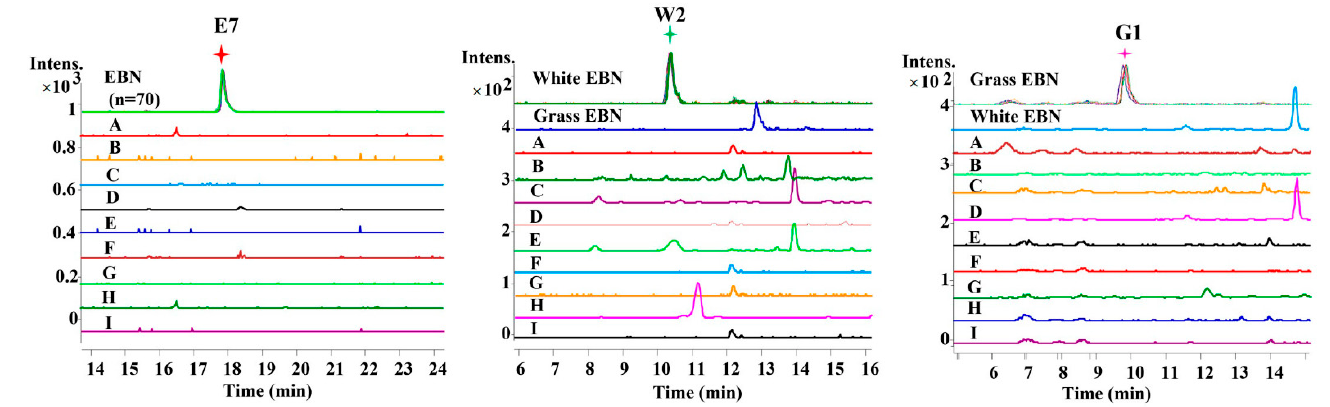
Figure 3. Extracted ion chromatograms (EIC) of selected peptide markers specific to EBN in a typical batch of digested EBN (overlapped) and related adulterants. The adulterants include agar (A), chicken egg white (B), gelatin (C), cow milk (D), pork skin gelatin (E), rice (F), starch (G), swim bladder (H) and tremella fungus (I).